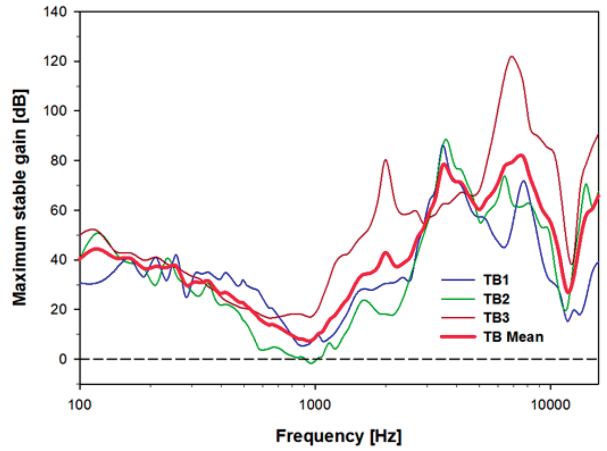
Figure 8. Maximum stable gain (MSG) of the trans-tympanic microphone when the round window was driven by a vibrational transducer at a level equivalent to 94 dB SPL at the ear-canal entrance, for TB1–3 and the mean